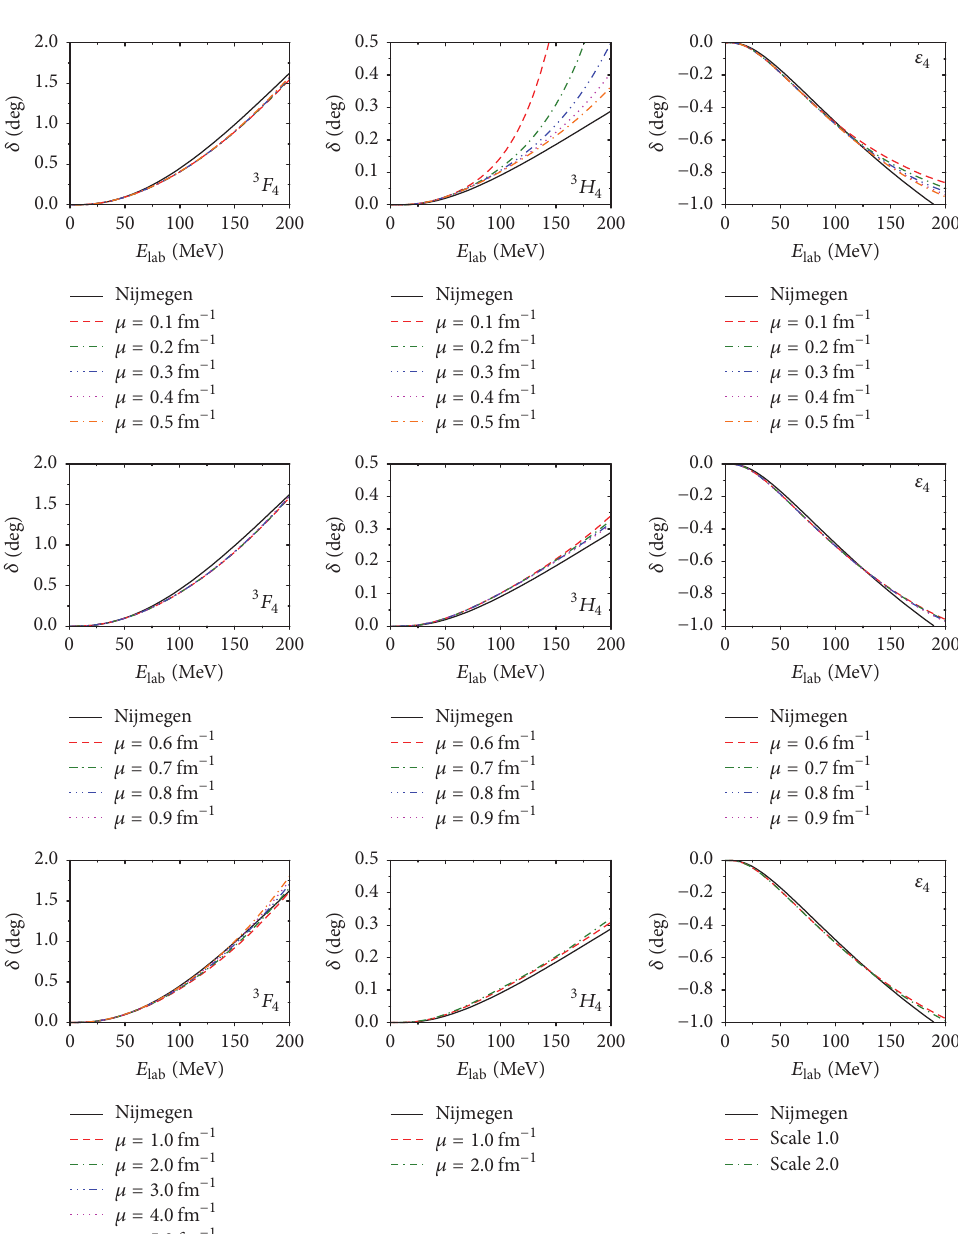
Figure 11: (Color on-line) phase shifts in 3 𝐹 4 − 3 𝐻 4 coupled channels calculated from the solution of the subtracted LS equation for the 𝐾 - matrix with five subtractions for the N3LO-EGM potential for several values of the renormalization scale compared to the Nijmegen partial wave